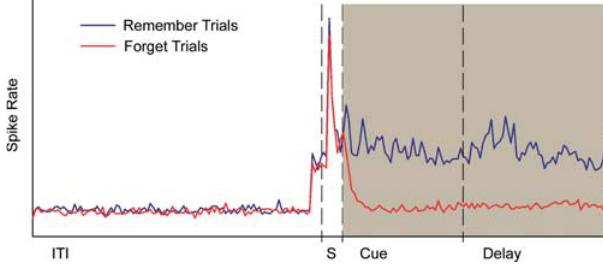
Figure 4. The Response Profile of Excitatory Delay Neurons The response profile of all 102 instances of excitatory delay activity on remember and forget trials. To account for differences in firing rates between the neurons, each neuron’s firing rate was normalized against its baseline firing rate. The cue and the delay periods are shaded in grey. The vertical dashed lines separate the different periods of the task. ITI, intertrial interval; S, sample period. DOI: